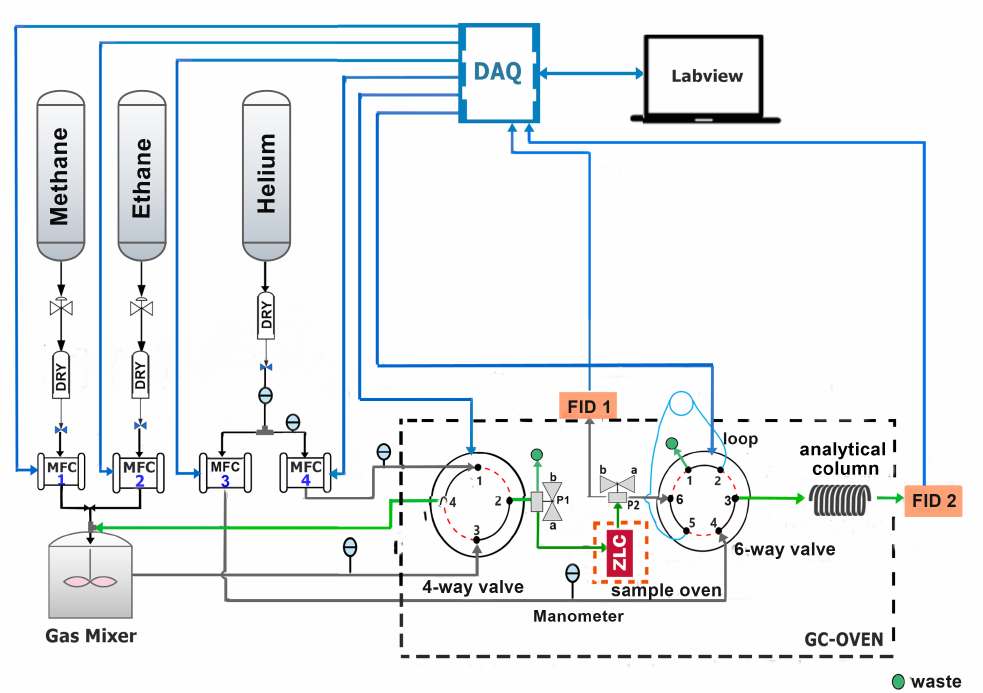
Figure 1. Schematic drawing of the semi-automatic experimental apparatus to determine: diffusion coefficients and adsorption isotherms of pure gases and